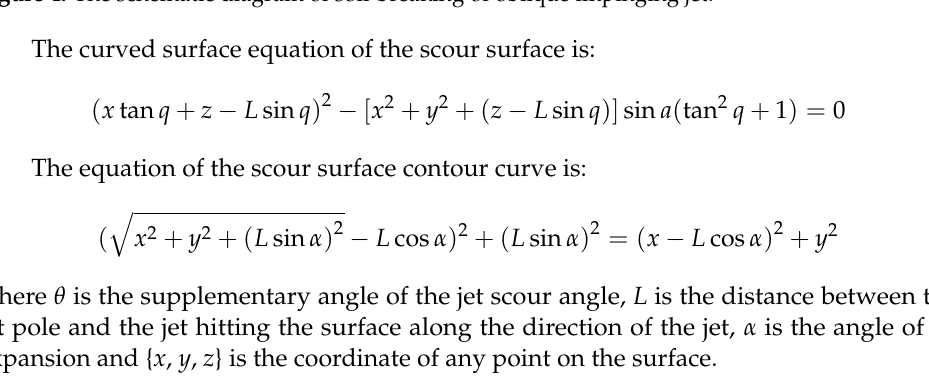
Figure 4. The schematic diagram of soil-breaking of oblique impinging jet.